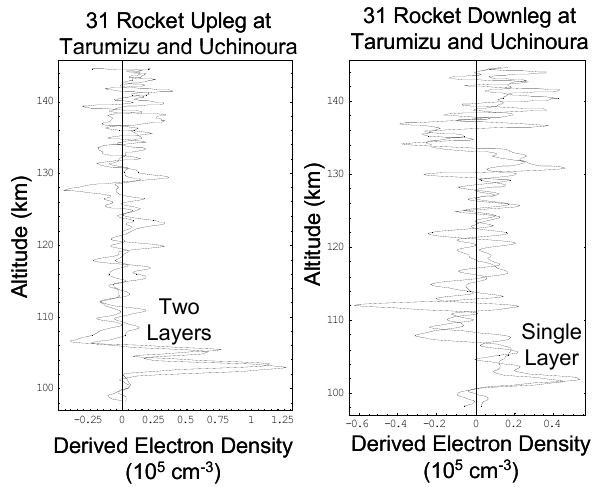
Figure 6. Profiles of apparent electron density computed from altitude derivatives of vertical TEC. The independent measurements at Tarumizu and Uchinoura yield similar upleg and downleg profiles of electron density in the 100 to 110 km altitude range.